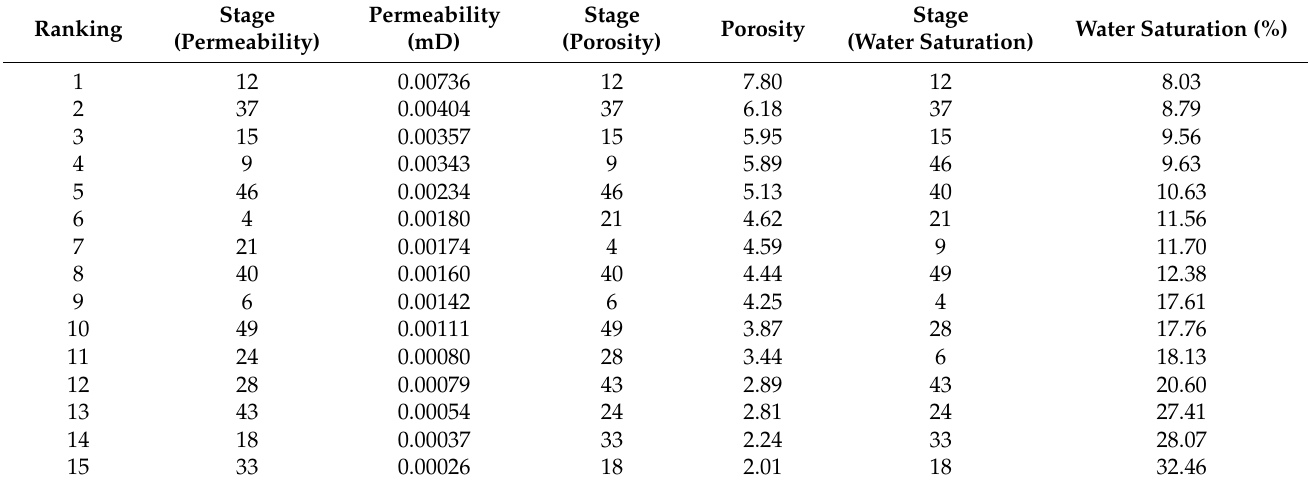
Table 6. Permeability, porosity, and initial water saturation-based ranking for the selected